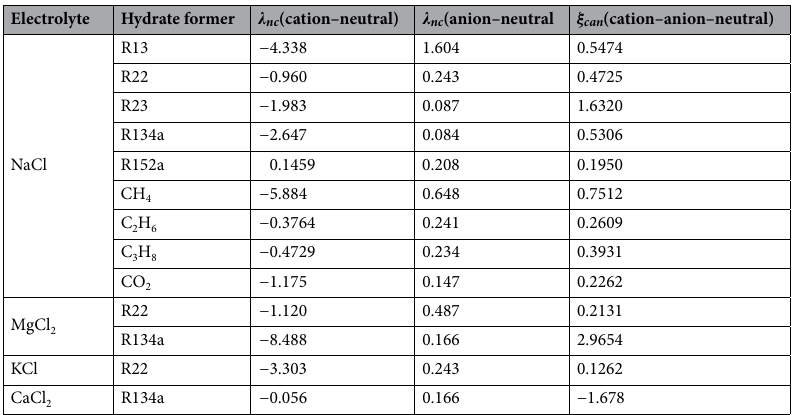
Table 5. Binary and ternary interaction parameters of Pitzer activity coefficient model.